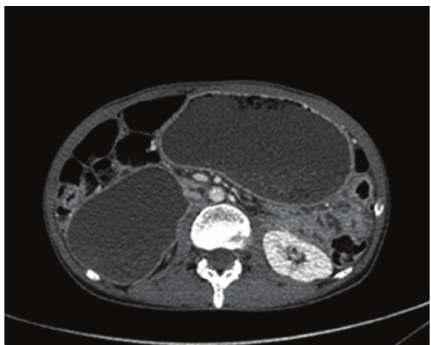
Figure 1: Abdominal computed tomography showing gastric and duodenal distension related to an irregular thickening with stenosis localized to genus inferius duodenal